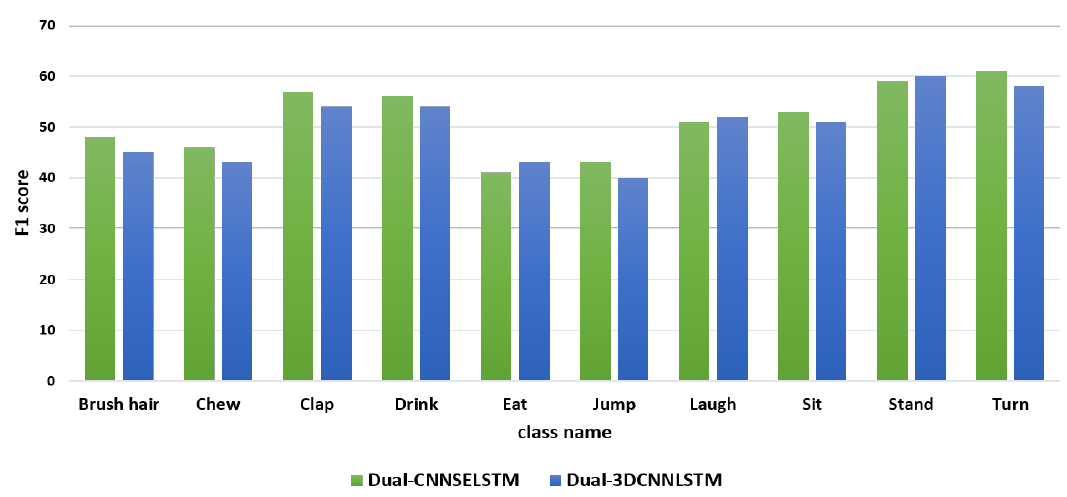
Figure 8. Class-wise accuracy among the best 10 classes of HMDB51 dataset.